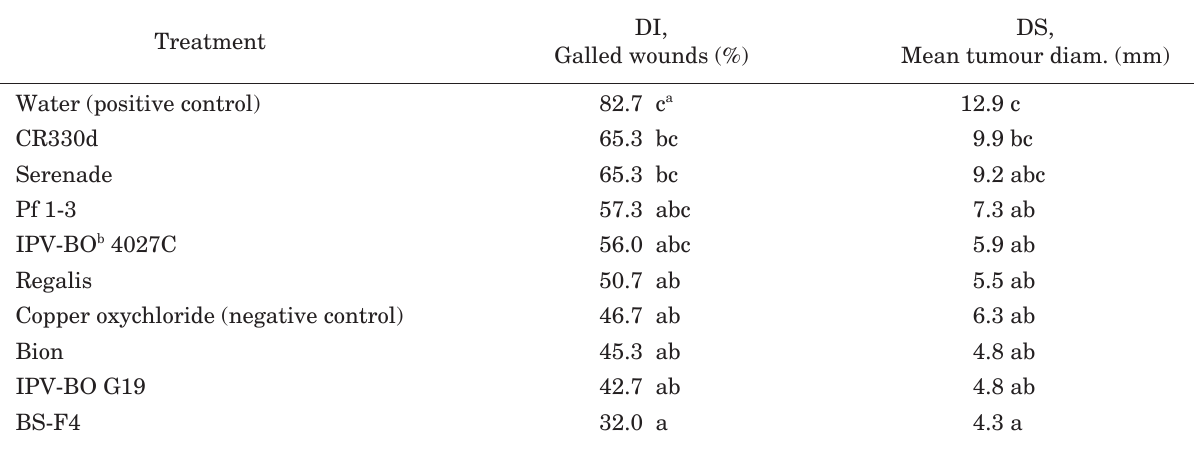
Table 1. Glasshouse experiment. Disease incidence (DI) related to the percentage of tumoured sites experimentally inoculated